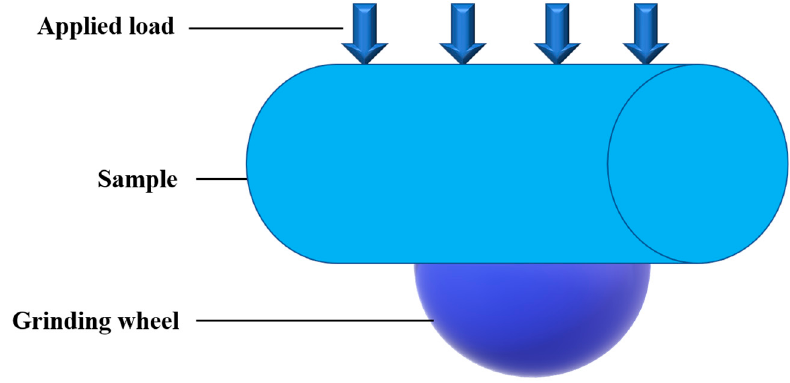
Figure 3. Schematic diagram of wear testing equipment.